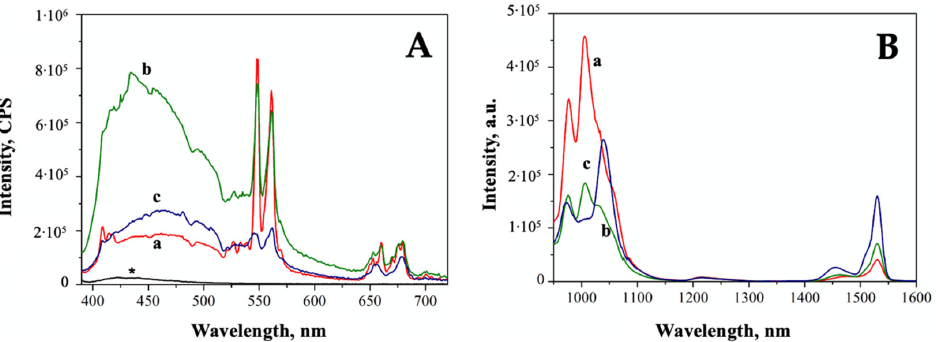
Figure 3. Fluorescence spectra of ZEY2 (curve a, red), ZEY5 (curve b, green), and ZEY10 (curve c, blue) in the Visible region ( A ) upon excitation at 377 nm and in the NIR region ( B ) upon excitation at 910 nm. Fluorescence spectrum of pure ZrO 2 is reported in section A (black curve, *) for the sake of